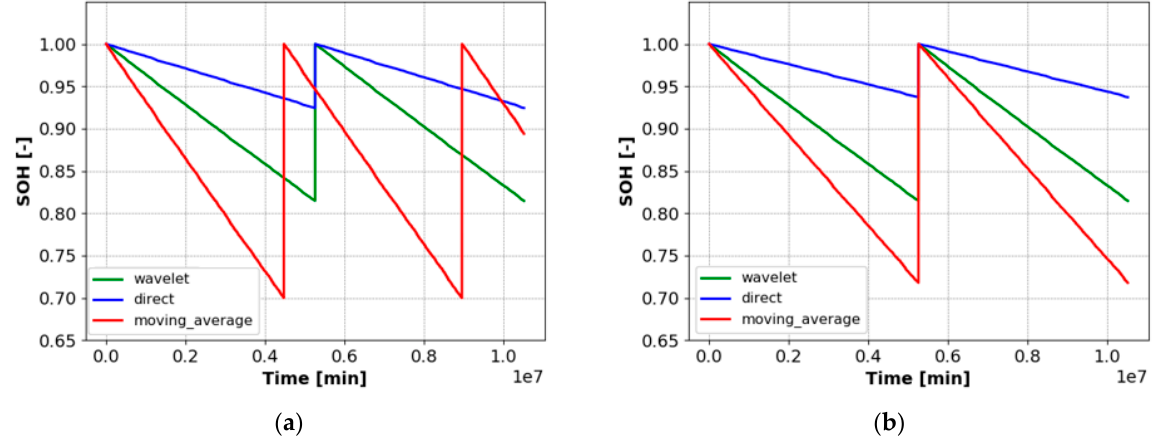
Figure 22. SOH profiles ( a ) capacity = 330 kWh ( b ) AR = 90%.